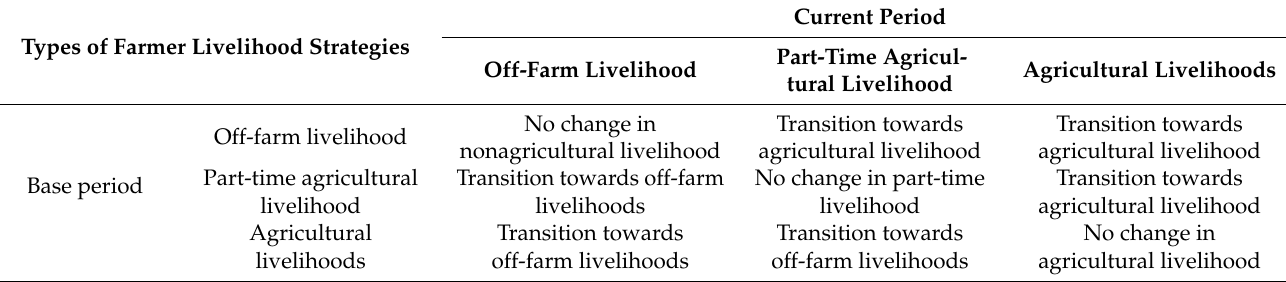
Table 1. Changes in household livelihood